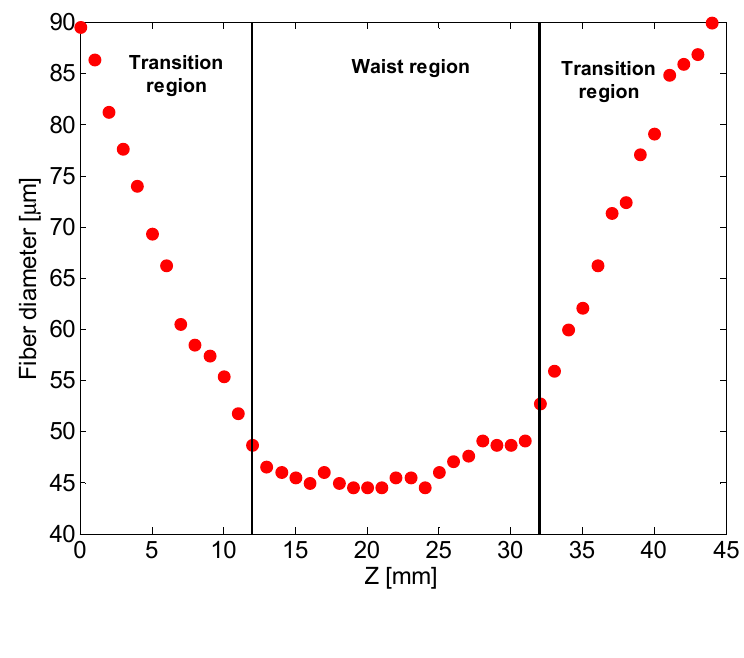
Figure 5. Plot of fiber diameter vs. the position on the fiber axis (z